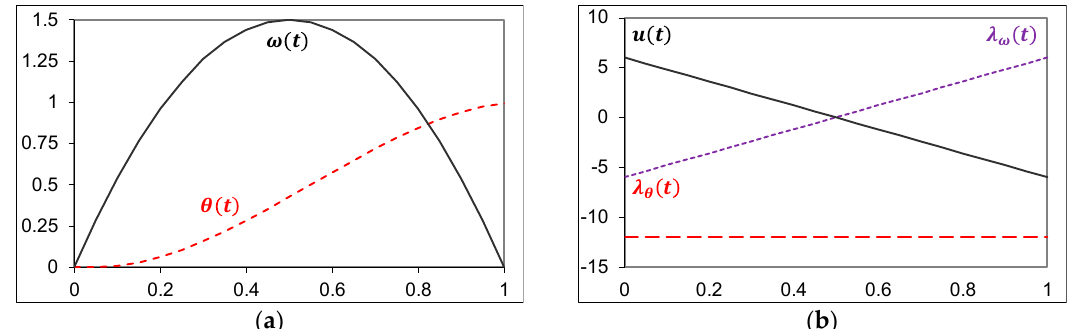
00.250.50.7511.251.5 Figure 1. External states, co ‐ states, and control for optimally controlled double integrator plant with time on the abscissa and values on the ordinate. ( a ) State trajectories, θ (t) and ω (t) from Equations (18)–(20). ( b ) Co ‐ state trajectories in shadow space λ _ θ (t) , λ _ ω (t) , and control u(t) solutions to Equations (12)–(15), and (17). Figure 2. SIMULINK model of optimal controlled double integrator plant with noise added. 2.2. Continuous Predictive Closed Loop Optimum Controller This section briefly describes the implementation of a feedback optimum controller where the constants of integration are continuously calculated by the controller instantaneously. The basis of the derivation begins with the previously mentioned solution to the optimization problem, substantiating